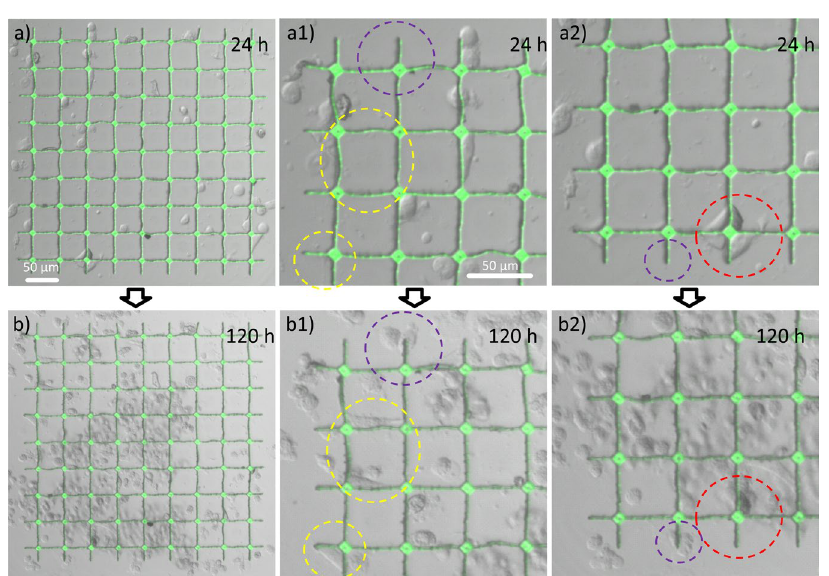
Figure 6. Combined confocal and optical transmission microscopy images of HeLa cells incubated on gold- coated 3D microstructures after 24 h ( a ), and zoom images in ( a1 , a2 ) and after 120 h in ( b ) with zoom into selected areas given in ( b1 , b2 ). We highlight areas in purple and yellow, where at 24 h of incubation no cells are present, while after additional 96 h of incubation, individual cells attach to walls or edges, respectively. The red circle indicates the opposite situation, where cells are attached to walls at 24 h of incubation, that relocate during the following 96 h leaving empty wall segments